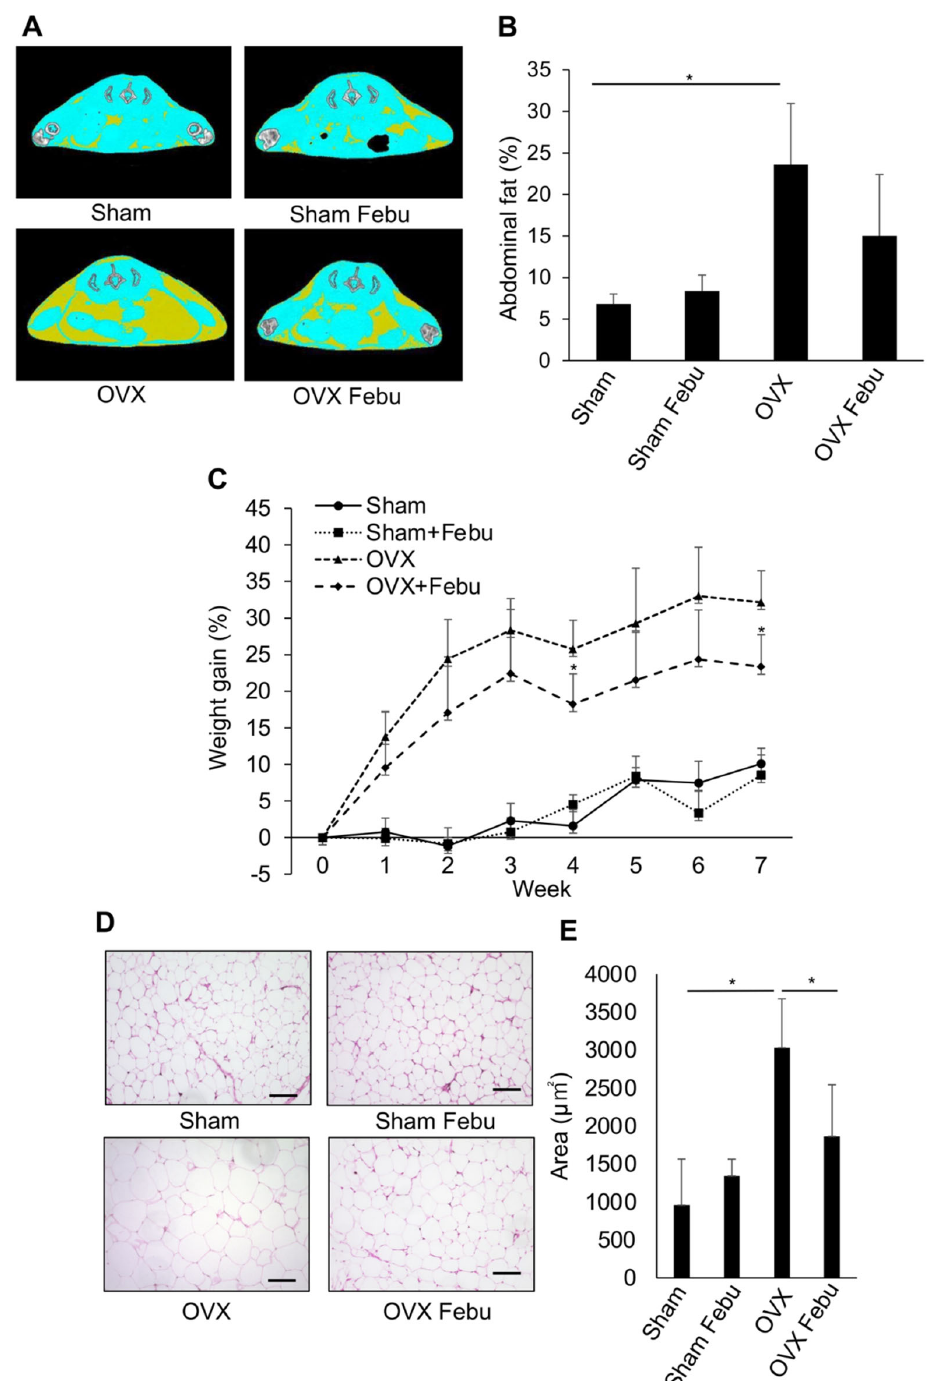
abdominal fat volume from the level of 1st to 6th lumbar vertebrae using micro ‐ CT images at 10 weeks. n = 5 per group. Results are expressed as the mean ± SD. * p < 0.05. ( C ) Percent increase in body weight from baseline in RD and HFD mice with or without Febu treatment is shown. n = 5 per group. Results are expressed as the mean ± SD. * p < 0.05 vs. HFD at the indicated time point. ( D ) Representative images of hematoxylin and eosin (H&E) staining of the visceral white adipose tissue. Original magnification, ×200. Bar, 100 μ m. ( E ) The area of adipocytes was measured. n = 5 per group. Results are expressed as the mean ± SD. * p < 0.05.